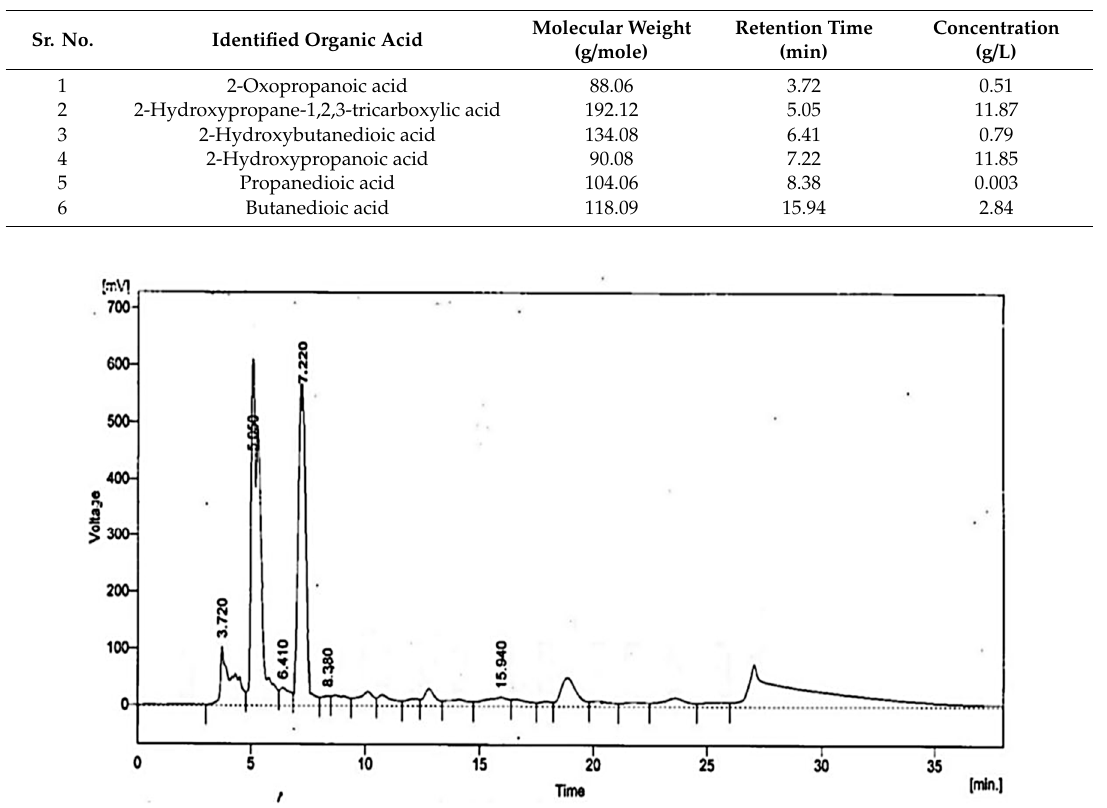
Figure 4. HPLC analysis of L. coryniformis BCH-4 AMCs for organic acids. The chromatogram has been labeled with peak retention time, i.e., 2-oxopropanoic acid (3.72 min), 2-hydroxypropane-1,2,3-tricarboxylic acid (5.05 min), 2-hydroxybutanedioic acid (6.41 min), 2-hydroxypropanoic acid (7.22 min), propanedioic acid (8.38 min) and butanedioic acid (15.94 min). Table 2. Acid profile of L. coryniformis BCH-4 AMCs with their respective molecular weight, retention time and concentration.